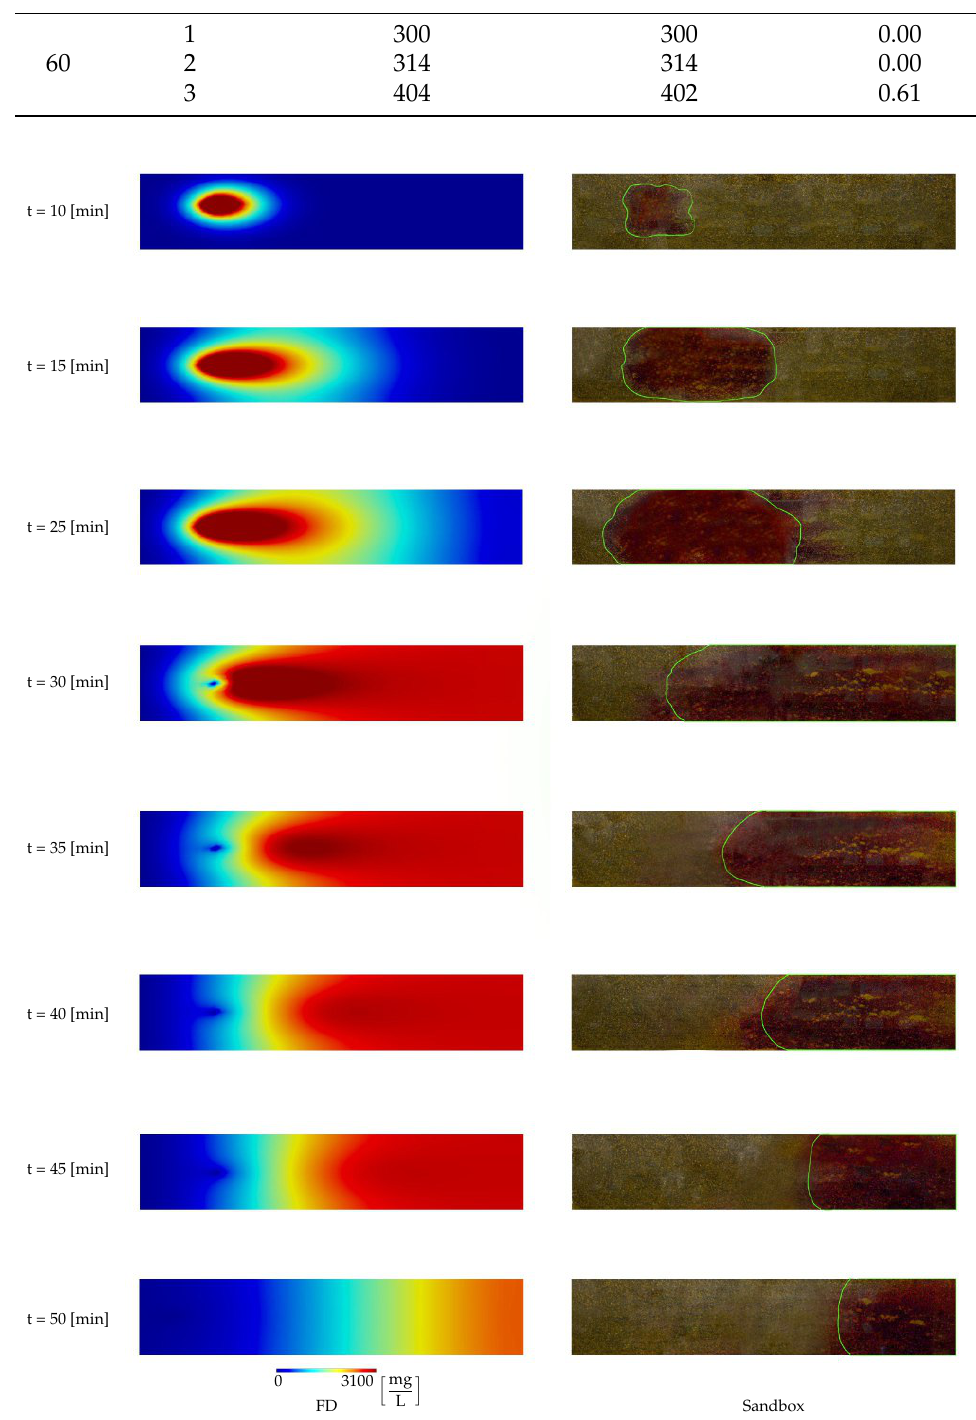
Figure 4. The comparison between observed and FD predicted plume.